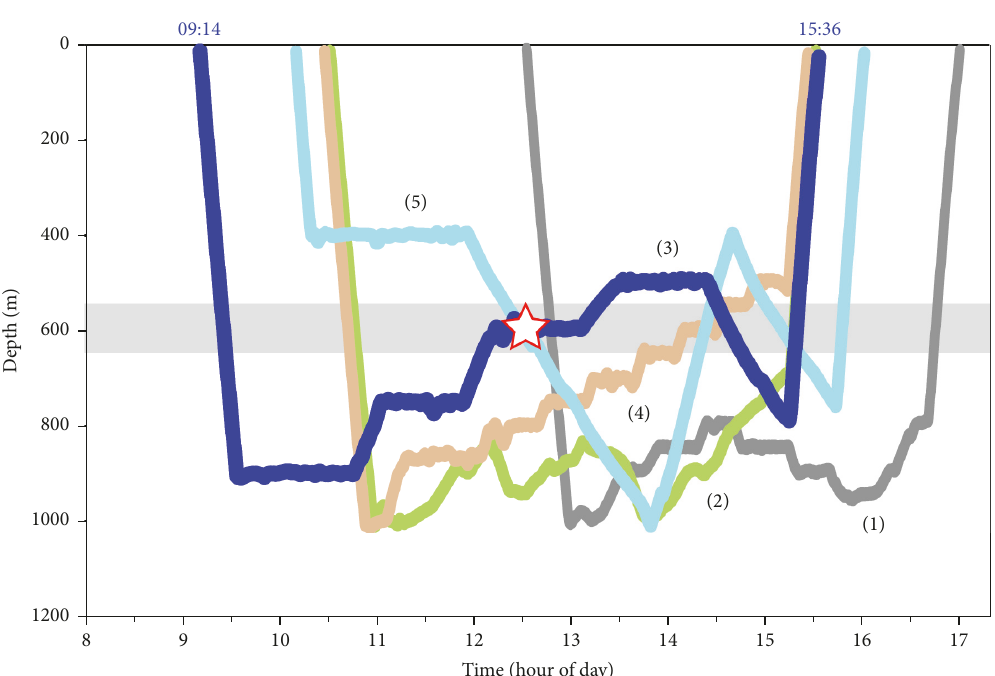
Figure 2: Time-depth plots of the 5 Shinkai 6500 submersible dives made during the YK17-10 underwater survey near the southern West Mariana Ridge in May 2017. The star shows the location when the gelatinous giant octopod, Haliphron atlanticus, was seen and the shaded area shows the general depth layer where the octopus was seen for evaluating how much observation effort occurred at that zone during the submersible